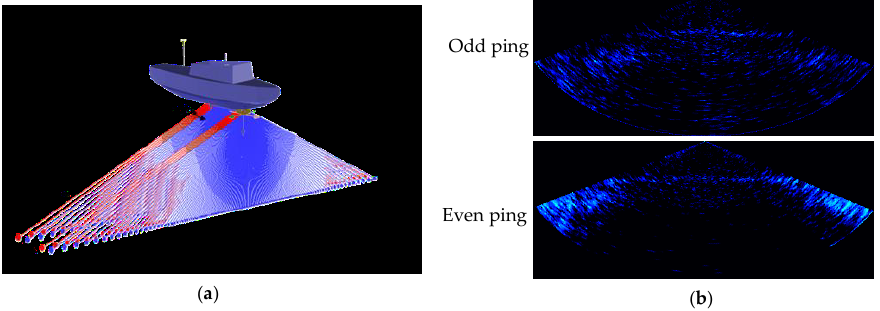
Figure 10. ( a ) Denotes the dual-swath emissions, and ( b ) shows the background noise of odd and even pings.